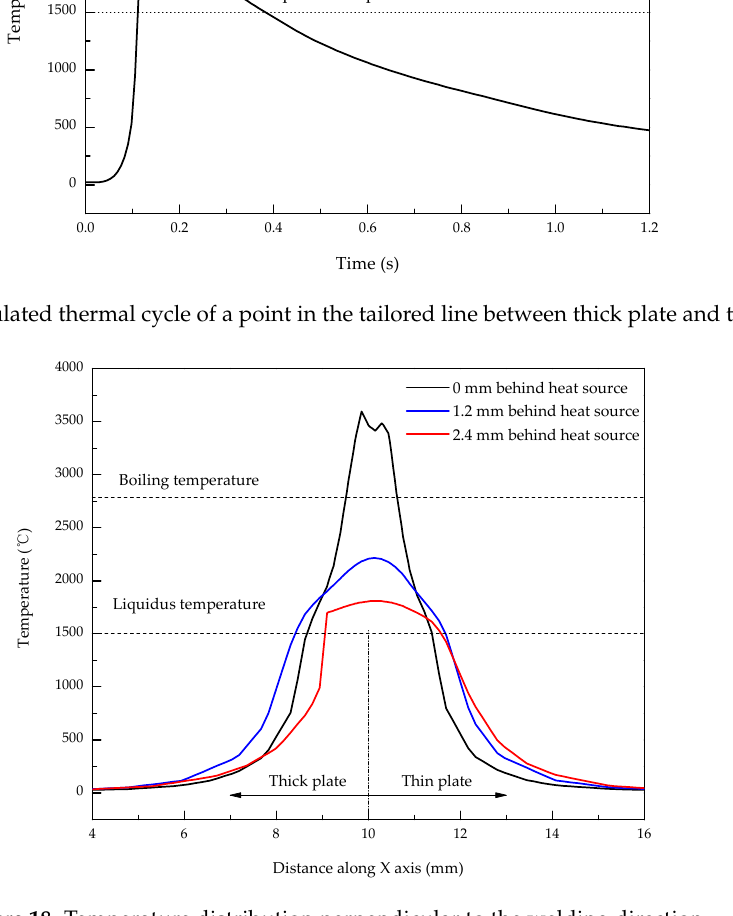
Figure 18. Temperature distribution perpendicular to the welding direction.